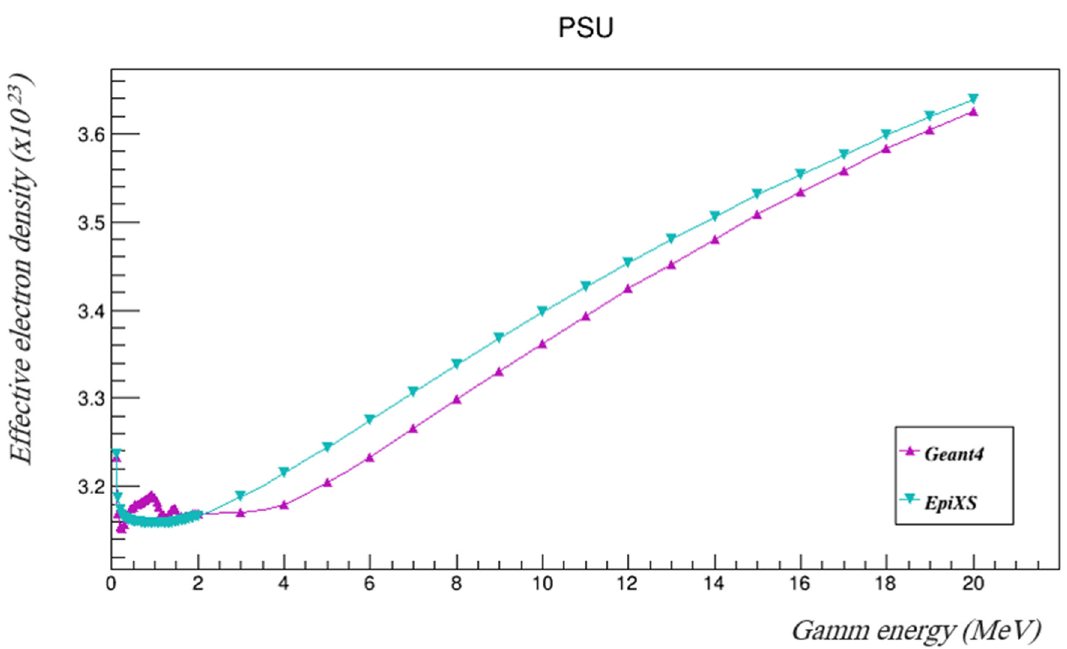
Figure 6. The effective electron densities of PSU with the investigated gamma energies using both Geant4 and EpiXS.